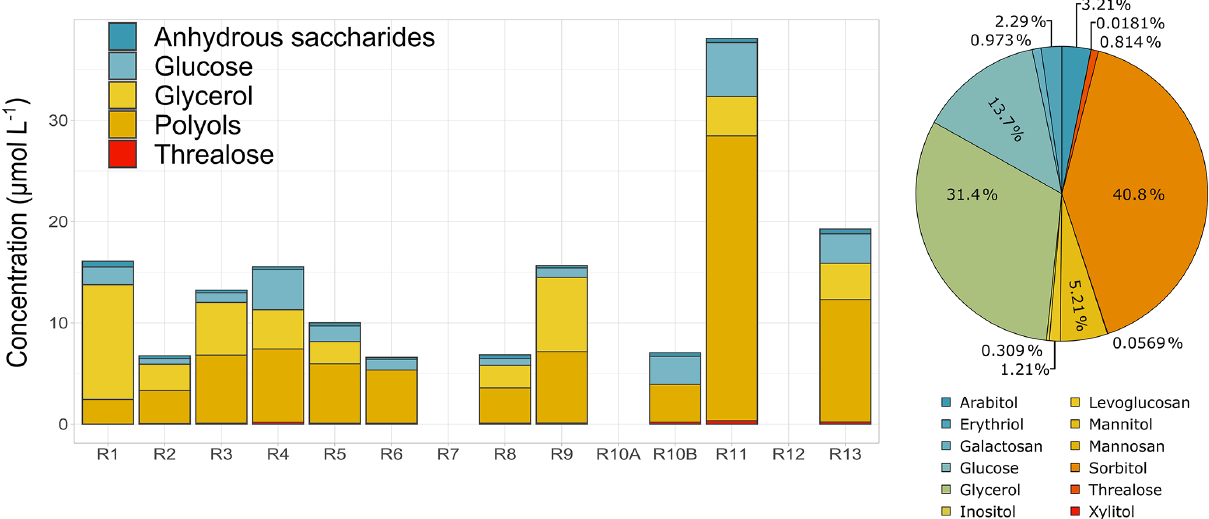
Figure 5. Concentrations of polyols, anhydro saccharides, and monosaccharides and total average relative contributions of sugars observed in cloud waters. R1 to R13 refer to individual cloud